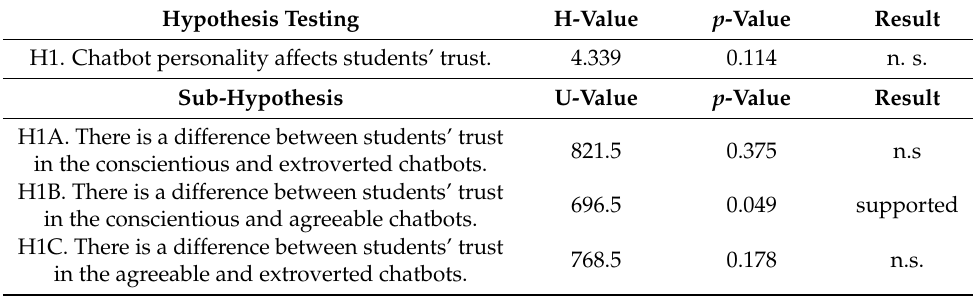
Table 3. Hypothesis 1 Testing Results.